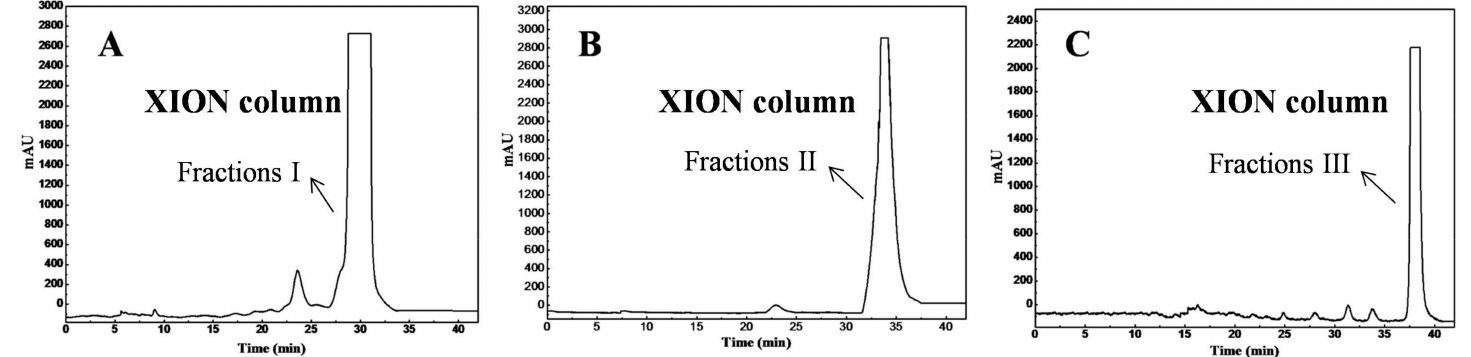
Figure 2. The analytical chromatograms of target fractions I ( A ), II ( B ) and III ( C ) on a XION analytical column. Conditions of ( A ), ( B ), and ( C ): mobile phase A: n -hexane, and mobile phase B: ethanol; gradient: 0–8.4 min, 0%~0% B; 8.4–16.8 min, 5%~5% B; 16.8–25.2 min, 10%~10% B; 25.2–33.6 min, 20%~20% B; 33.6–42 min, 30%~30% B. Other conditions: monitoring wavelength: 254 nm; flow rate: 1 mL/min; injection volume: 10 µ L; column temperature: 25 ◦